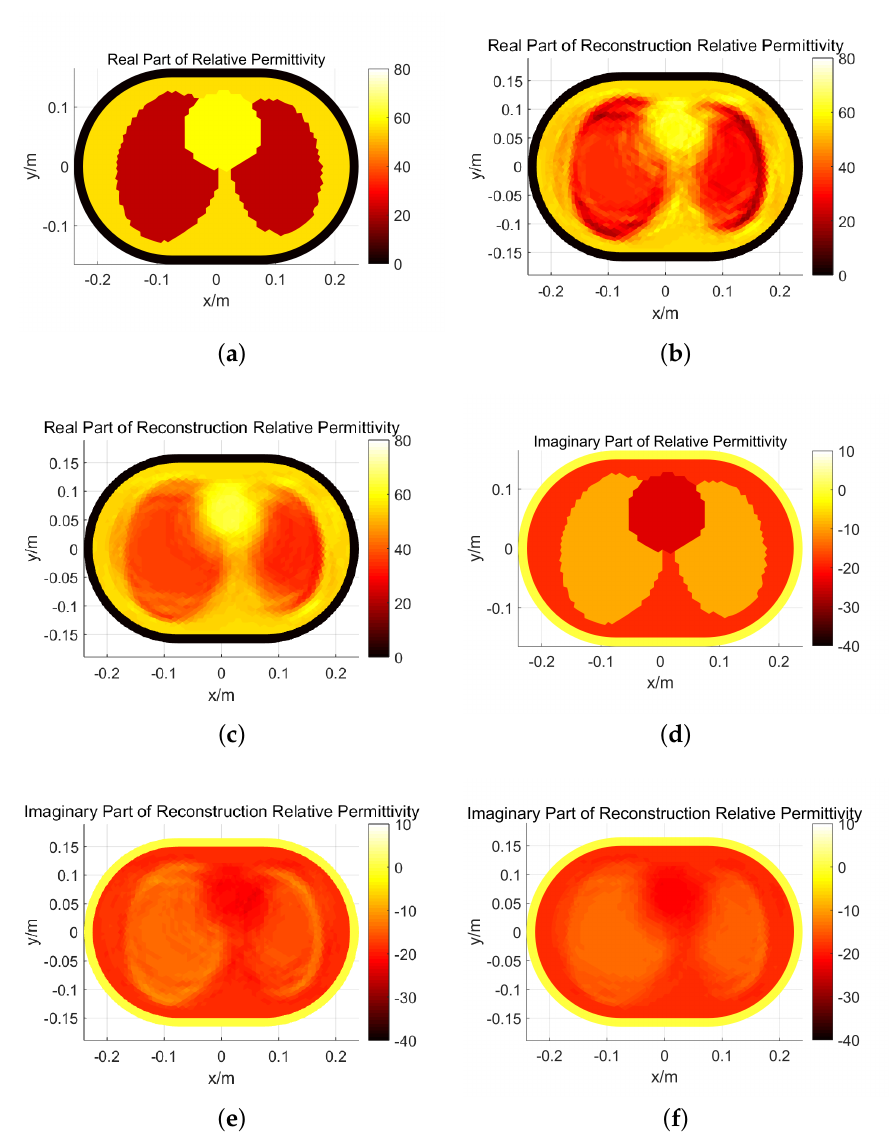
Figure 7. Thorax model for testing at 915 MHz: ( a , d ) Real model; ( b , e ) 10-step reconstruction; ( c , f ) One-step